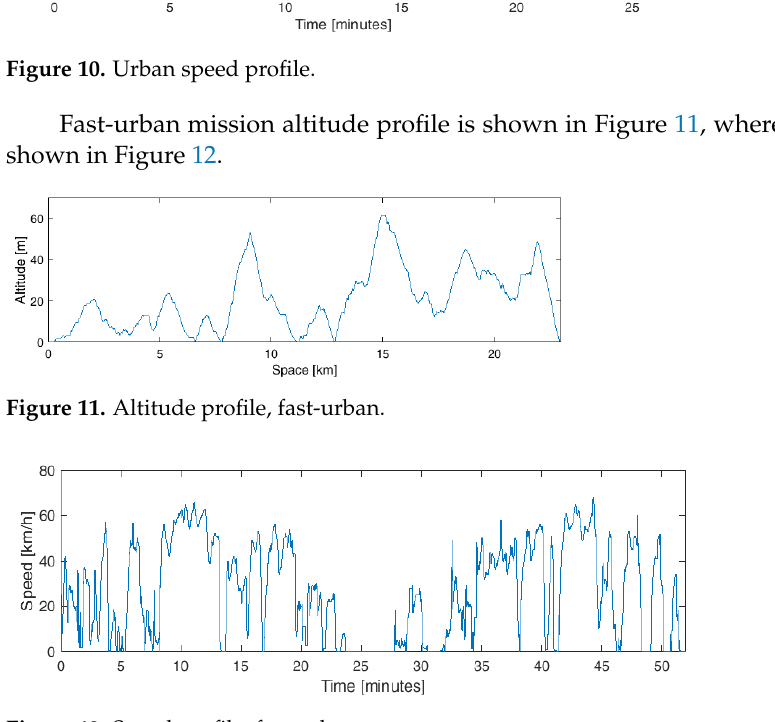
Figure 12. Speed profile, fast-urban.